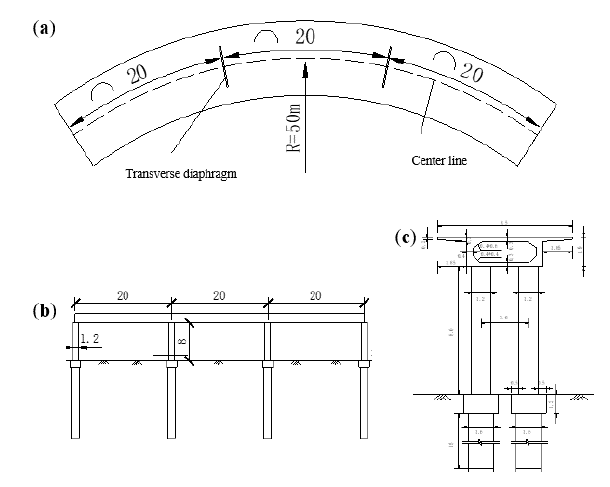
Figure 2. Geometry of the CCGB: ( a ) plane view; ( b ) elevation view; ( c ) cross-sections of piers and curved girder; unit: